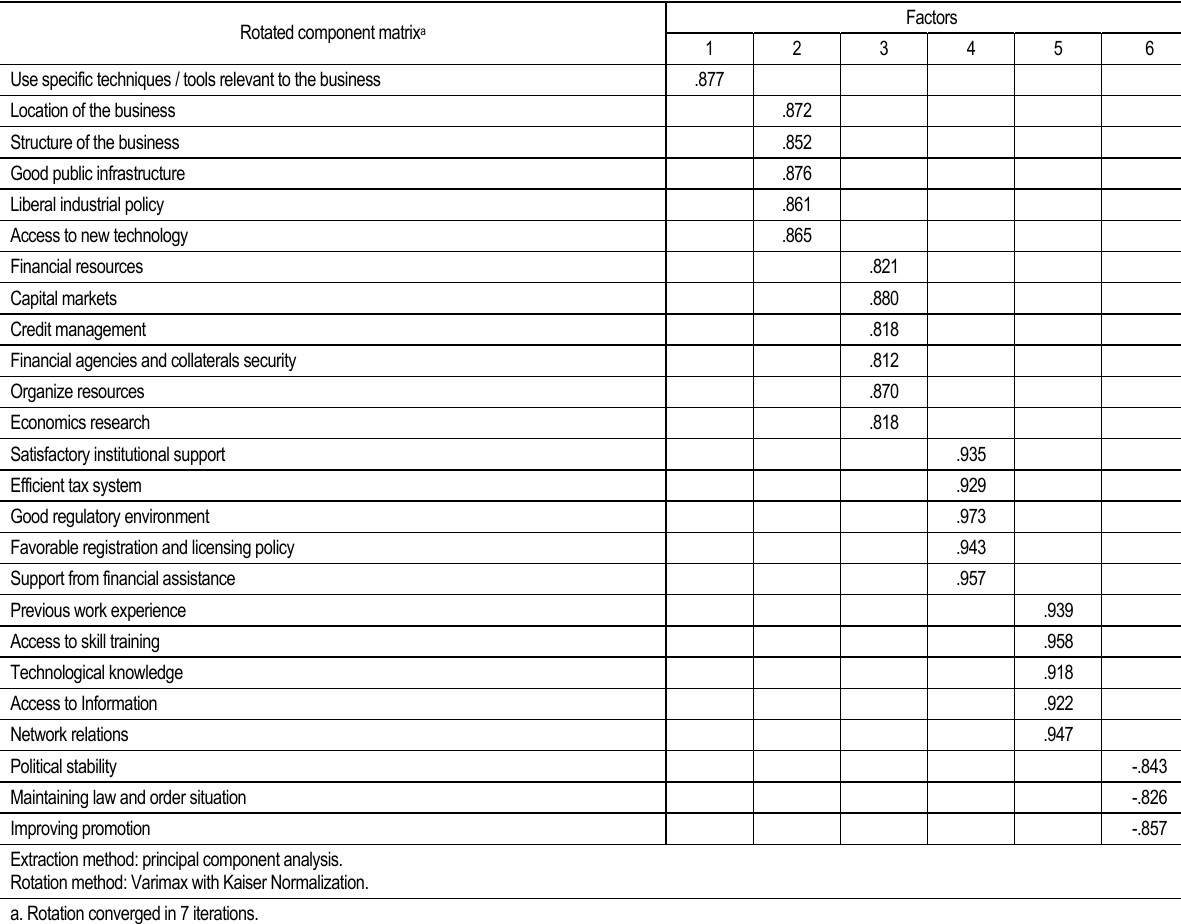
Table 6 (cont.). Factor loadings of correlation coefficient based on Varimax rotation of factors influencing entrepreneurship development and success